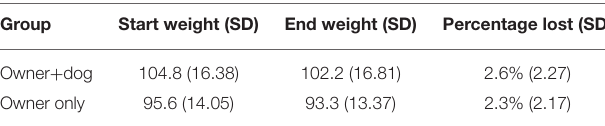
TABLE 2 | Weight loss results in dog owners of the human-centered trial.